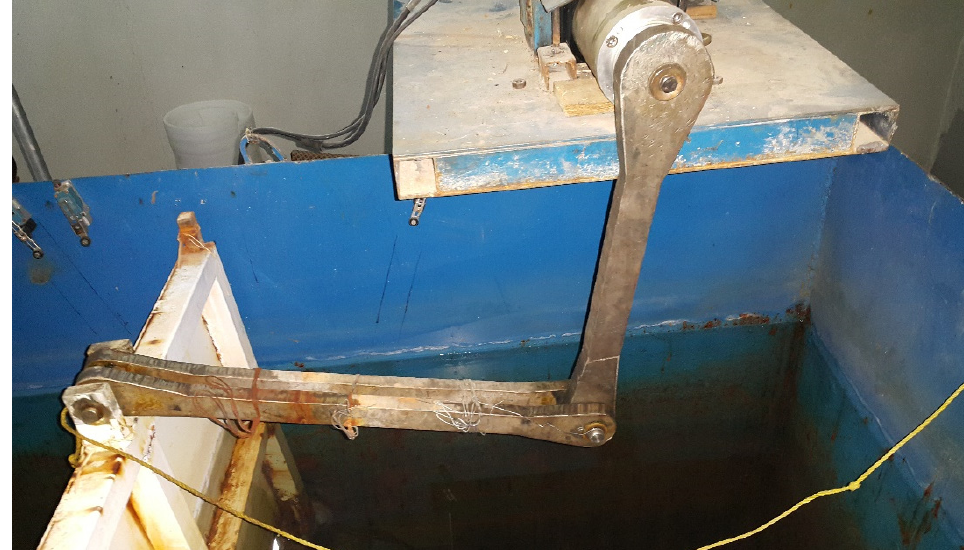
Figure 3. Two arms of the flap connected to the smart engine.